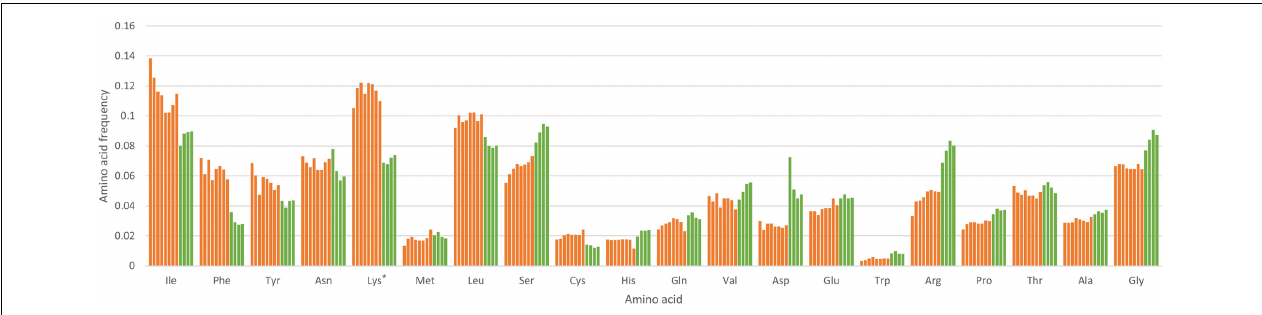
FIGURE 2 | Amino acid content of plastid genes in Thismia and photosynthetic Dioscoreales. Values for Thismia are depicted by orange bars, values for photosynthetic species by green bars. The species, from left to right: Thismia thaithongiana , Thismia hawkesii , Thismia lanternata , Thismia filiformis , Thismia mucronata , Thismia puberula , Thismia gardneriana , Thismia tentaculata , Burmannia coelestis , Burmannia disticha , Tacca chantrieri , Tacca leontopetaloides . Asterisk indicates statistically significant difference between Thismia species and photosynthetic species ( q -value <